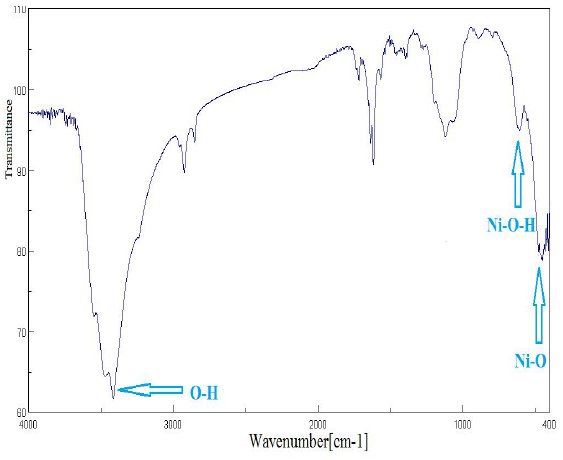
Fig. 10. FTIR spectrum of the NiO nanoparticle after calcinations at room